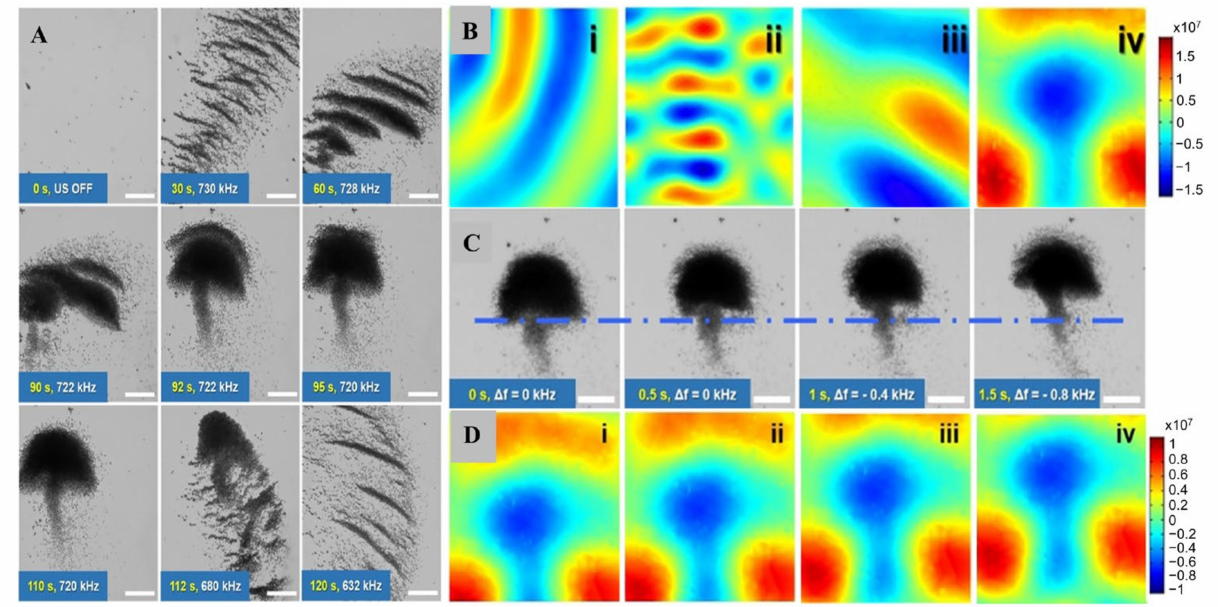
Figure 19. Reconfigurable assembly of ultrasonically driven MLMTs [21]. ( A ) Time-lapse images of acoustic-triggered dandelion-like assembly of EGaIn colloidal motors, including the formulation of a bud (0 to 30 s), flower bloom (60 s to 90 s), the process of fruiting (92 s to 110 s), and blowing in the wind (112 s to 120 s). Scale bars, 60 µ m (0 s), 30 µ m (30 s to 120 s). ( B ) Sound pressure field simulation for acoustic triggered dandelion-like assembly. The corresponding acoustic field frequencies of each simulation are: ( i ) 730 kHz, ( ii ) 728 kHz, ( iii ) 722 kHz, ( iv ) 720 kHz. ( C ) Time-lapse images of the collective motion of the EGaIn motor cluster. Scale bar, 40 µ m. ( D ) Sound pressure field simulation results correspond to the experimental results as shown in ( C ). Corresponding frequency changing are: ( i ) 0, ( ii ) − 0.4 kHz, ( iii ) − 0.6 kHz, ( iv ) − 0.8